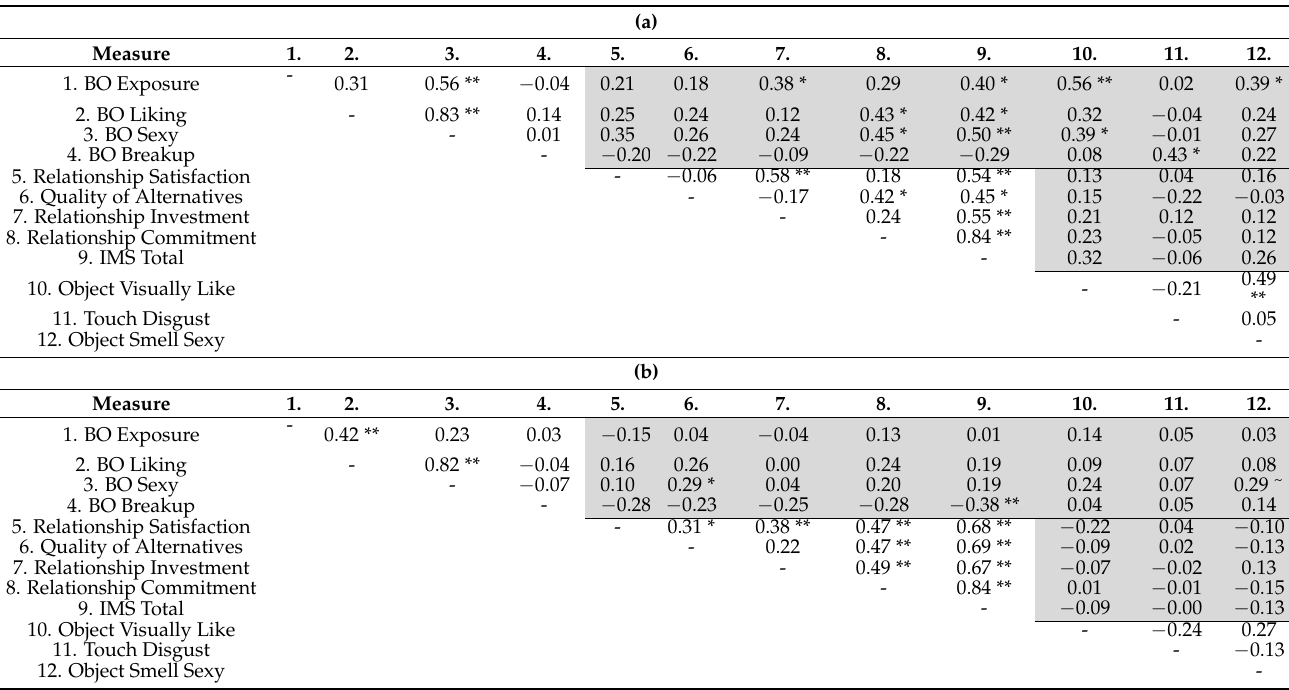
Table 3. ( a ). Spearman’s correlations between BO exposure (EXBO), relationship commitment (IMS), and object ratings (ORT)—single participants ( n = 32). ( b ). Spearman’s correlations between BO exposure (EXBO), relationship commitment (IMS), and object ratings (ORT)—partnered participants ( n = 48).